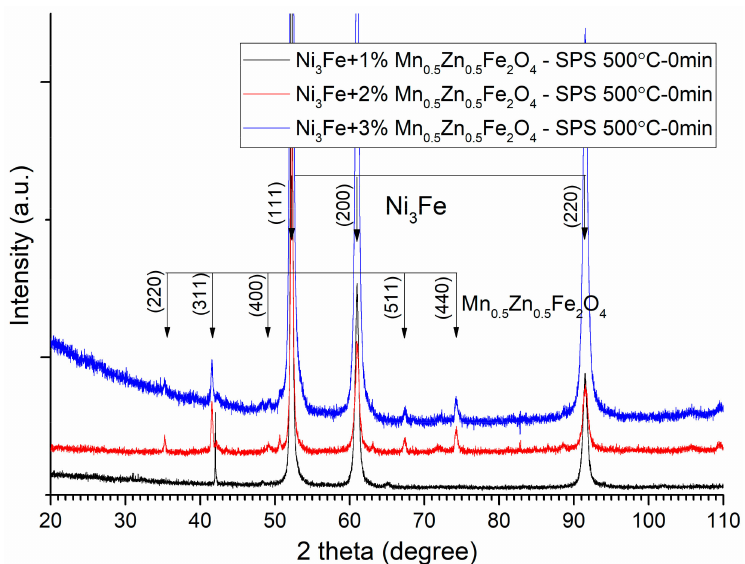
Figure 8. XRD patterns of the Ni 3 Fe/Mn 0.5 Zn 0.5 Fe 2 O 4 composite compacts with 1, 2, and 3 wt.% of MnZn ferrite obtained by SPS at sintering temperature of 500 ◦ C. For clarity, the XRD patterns have been shifted vertically.